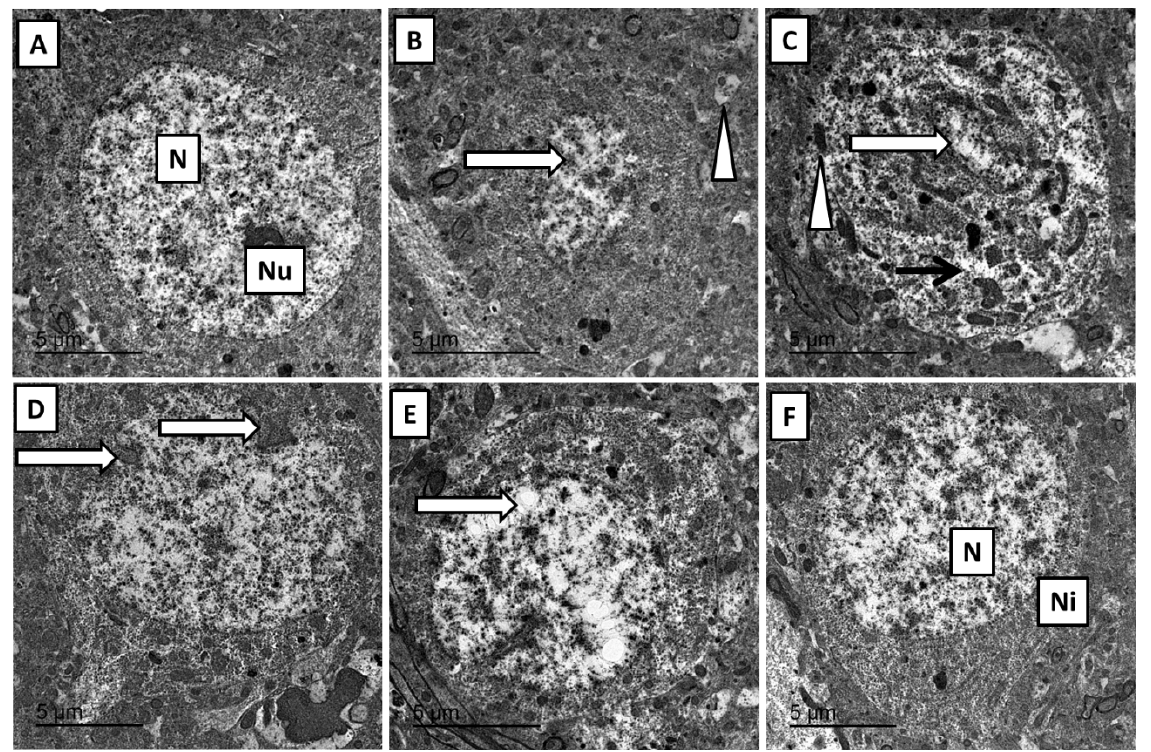
Figure 3. Representative TEM micrograph of brain ultrathin section from different treatment. ( A ) Control brain showing normal neuronal structure with a large euchromatic nucleus and prominent nucleolus beside normal cytoplasmic organelles. ( B ) Nicotine-exposed brain showing pyknosis of neuronal nucleus (thick arrow) with few mitochondrial swollen (arrowhead). ( C ) Nicotine-exposed brain showing necrotic neuron with severe, more pyknotic nucleus, disintegration of nissl granules (thin arrow), and shrunken irregularity of mitochondria (arrowhead). ( D ) Ginger-oil-exposed brain showing mild ultrastructure change in neuronal nucleus with chromatin clumping and nuclear membrane wrinkling (thick arrow). ( E ) Cinnamon-oil-exposed brain showing mild reduction in nuclear size with intranuclear vacuoles (thick arrow). ( F ) Combined group showing normal ultrastructural appearance of neuron with euchromatic nucleus (N), numerous free ribosomes (nissl granules) (Ni), and normal cytoplasmic organelles. Scale bar = 5 μm.